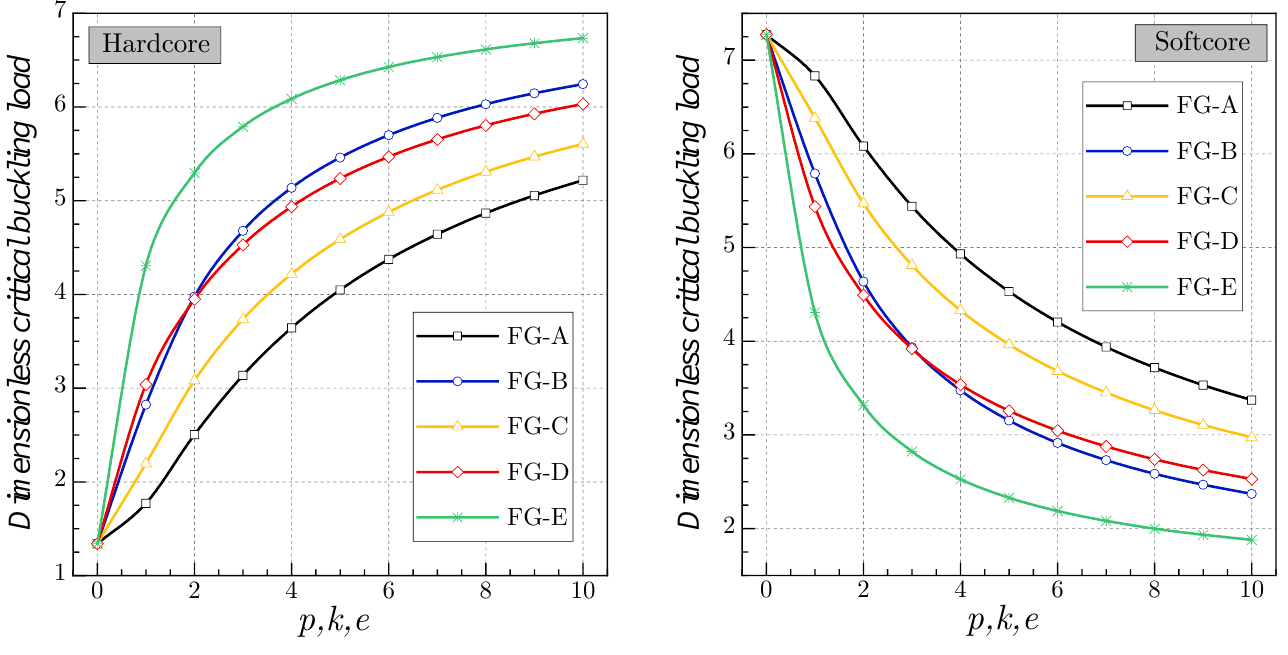
Figure 5. Dimensionless critical buckling load 𝑁̅ of FG shells for various material exponents p , k , and e (𝑆𝑆𝑆𝑆, 𝑅 = 5, 𝑏 = 𝑎 = 10ℎ, 𝜇 = 𝜆 = 𝐺 𝜁 = 𝐺 𝜂 = 𝐾 𝑤 = 0) .